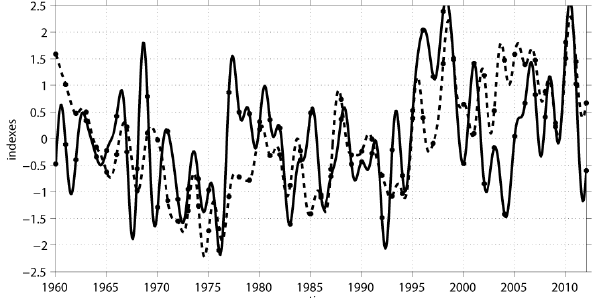
Figure 8. Normalized NAO(AMOC) (solid line; see text) and AMO index (dashed) after low-pass filtering with periods longer than 18 months, stars show January for each